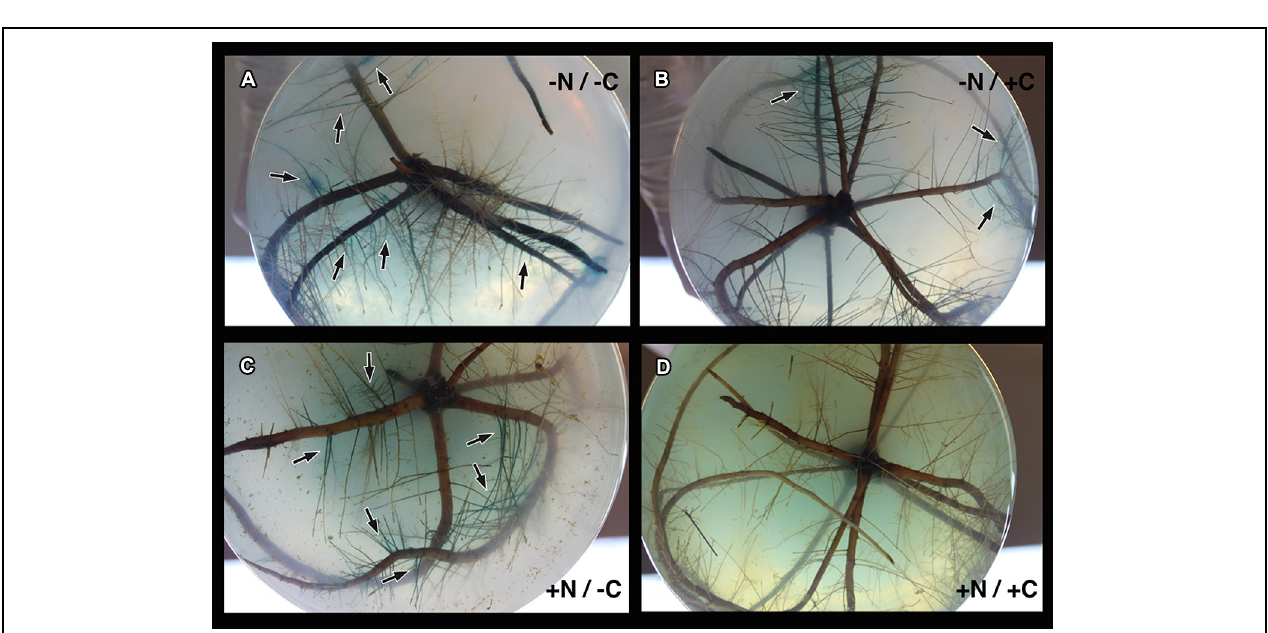
treatment. In (B,C) there is a weak and moderate bacterial colonization, respectively. (D) Gal22 fail to colonize R. mangle roots when the surrounding media was supplemented with nitrogen and carbon.